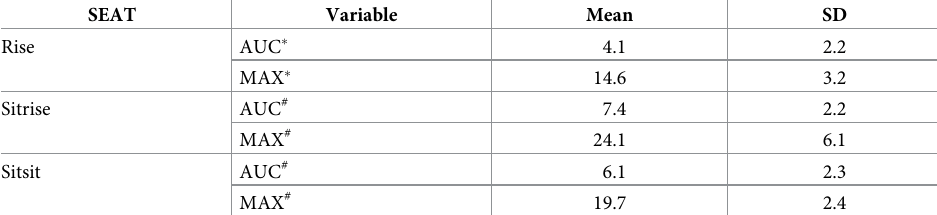
Table 1. Descriptive statistics of the saddle symmetry variables. Different superscripts ( (cid:3) , #) indicate significant dif- ferences, p < 0.05, for the statistical comparison between SEAT categories (sitting or rising in rising trot, or sitting in sit- ting trot), using horse mean